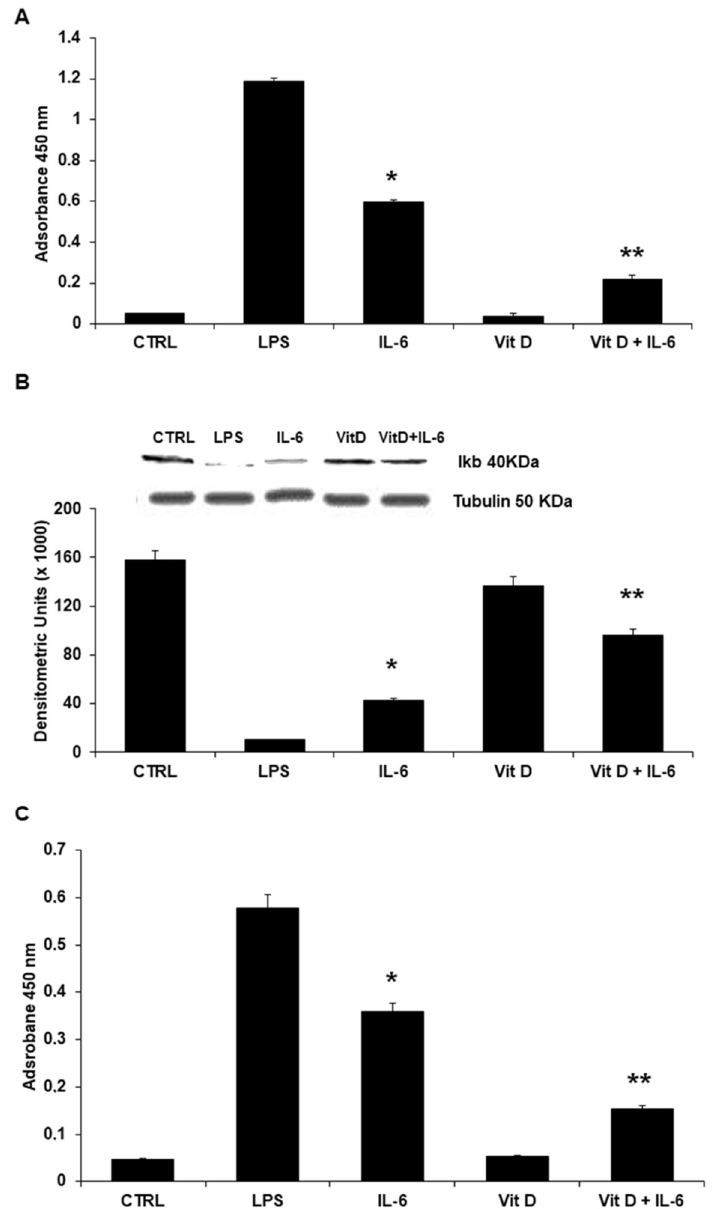
Figure 5. ( A ) In HUVEC incubated with IL-6, a significant increase of NF-kB levels was observed. Pretreatment of endothelial cells with VitD prevented the IL-6 effects on NF-kB. LPS served as positive control. Each bar represents the mean ± SD of 3 different experiments. (* p < 0.001 vs. Control; ** p < 0.001 vs. IL-6, one-way ANOVA with Tukey’s post hoc test). ( B ) Western blot analyses. IL-6 stimulation results in significant reduced levels of I κ B. Conversely, preincubation with VitD restores I κ B levels. LPS served as positive control. Each bar represents the mean ± SD of 3 different experiments. (* p < 0.001 vs. Control; ** p < 0.001 vs. IL-6, one-way ANOVA with Tukey’s post hoc test). The insert shows results of a representative experiment. ( C ) In HUVEC incubated with IL-6, a significant increase of STAT3 levels was observed. Pretreatment of endothelial cells with VitD prevented the IL-6 effects on STAT3. LPS served as positive control. Each bar represents the mean ± SD of 3 different experiments. (* p < 0.001 vs. Control; ** p < 0.001 vs. IL-6, one-way ANOVA with Tukey’s post hoc test) .